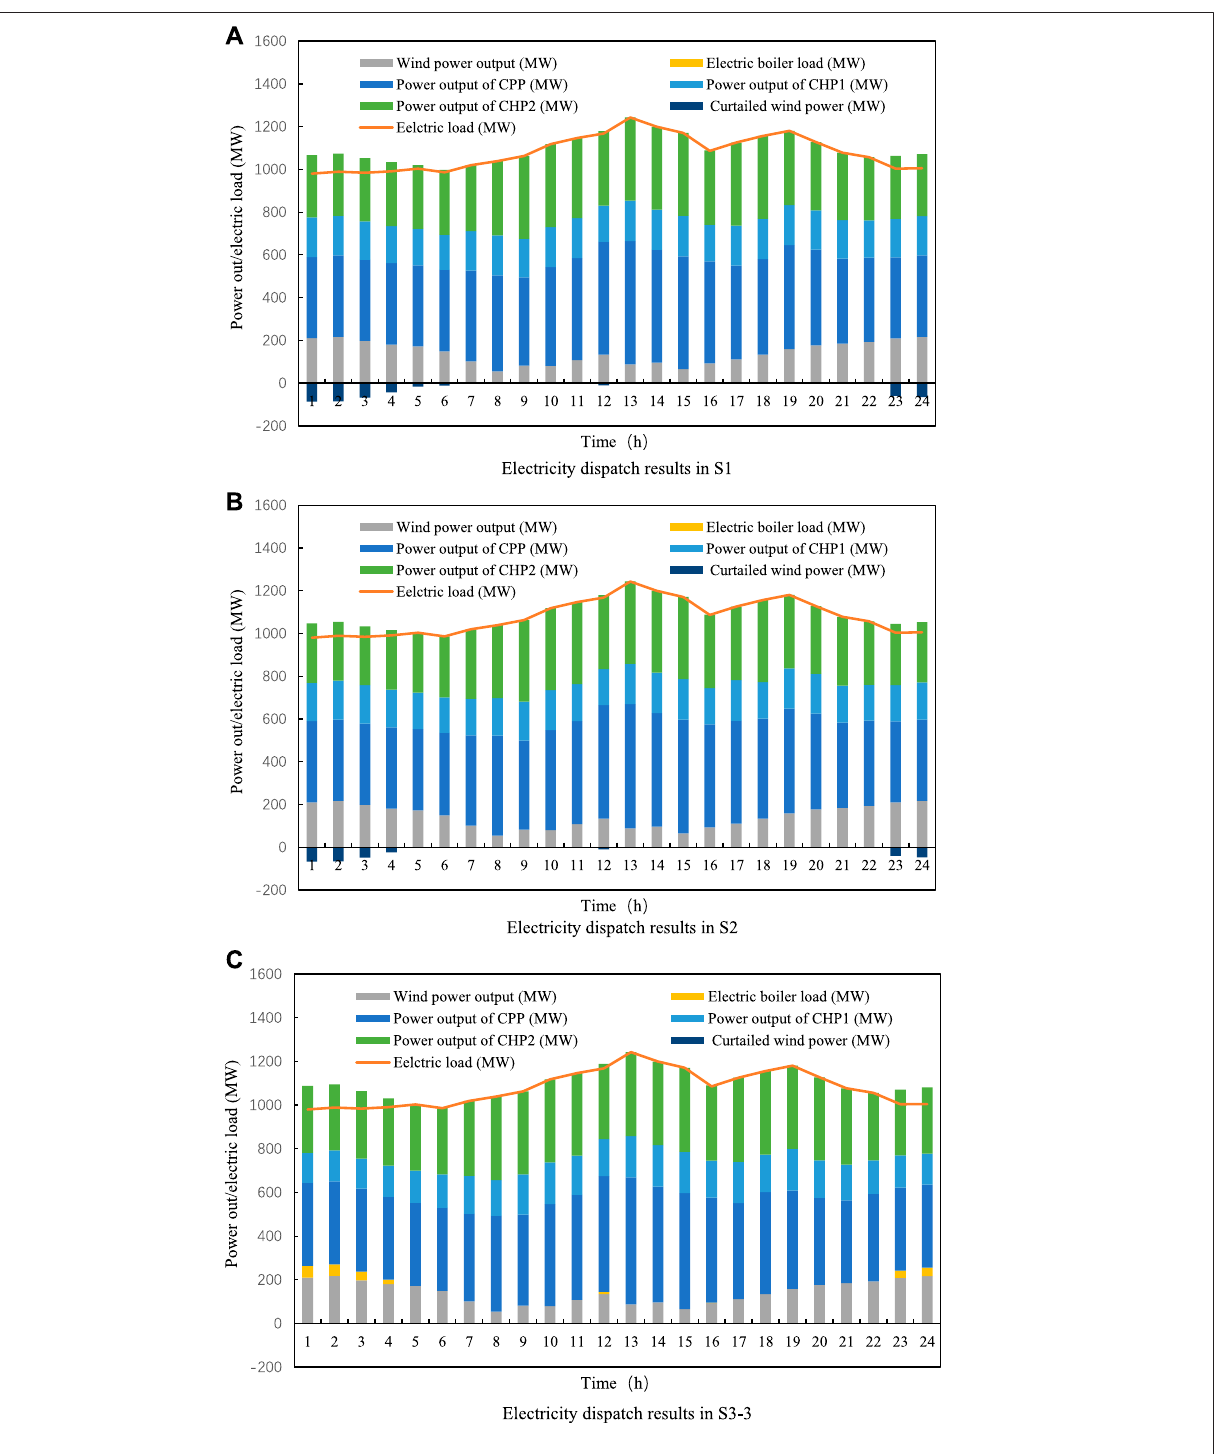
FIGURE 9 | Optimal electricity dispatch